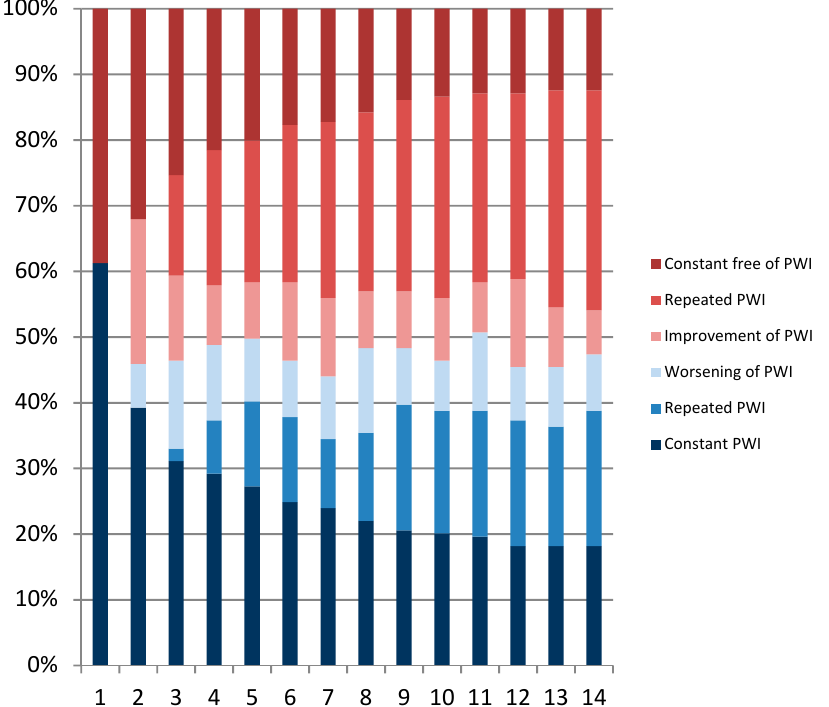
Figure 6. Patterns of episodes of pain-related work interference over one year. The figure shows the percentages of the population divided into different categories at each of the 14 measurement points. Improvement is categorized as a measurement with pain-related work interference (PWI) (an episode with PWI) followed by a measurement without PWI (recovery). Worsening is defined as a measurement without PWI followed by a measurement with PWI. Repeated PWI / repeated PWI free is defined as two or more successive measurements with PWI / no PWI.